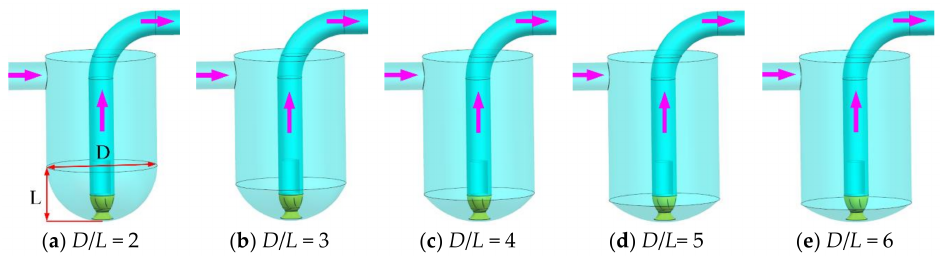
Figure 3. Five tank schemes with different tank bottom